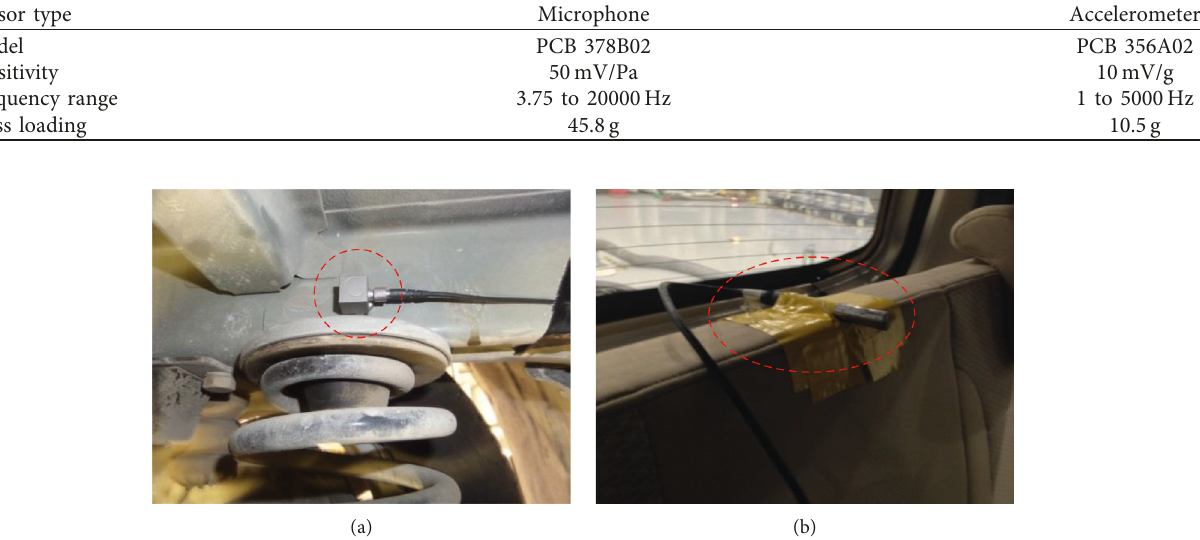
Figure 5: Sensor installation of minivan internal noise TPA test. (a) Vibration acquisition. (b) Interior noise acquisition.